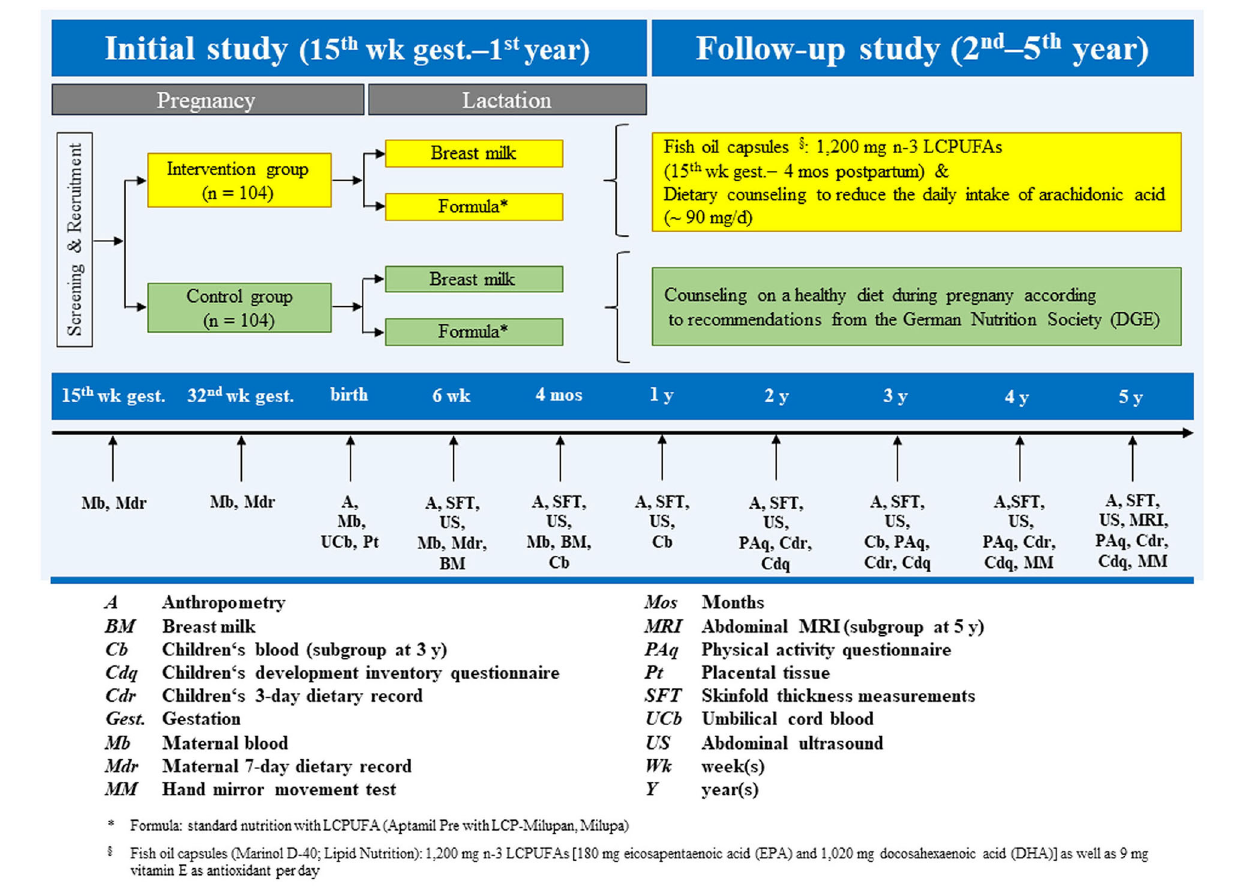
FIGURE 1 | INFAT study design, timeline, and overview of measurements and